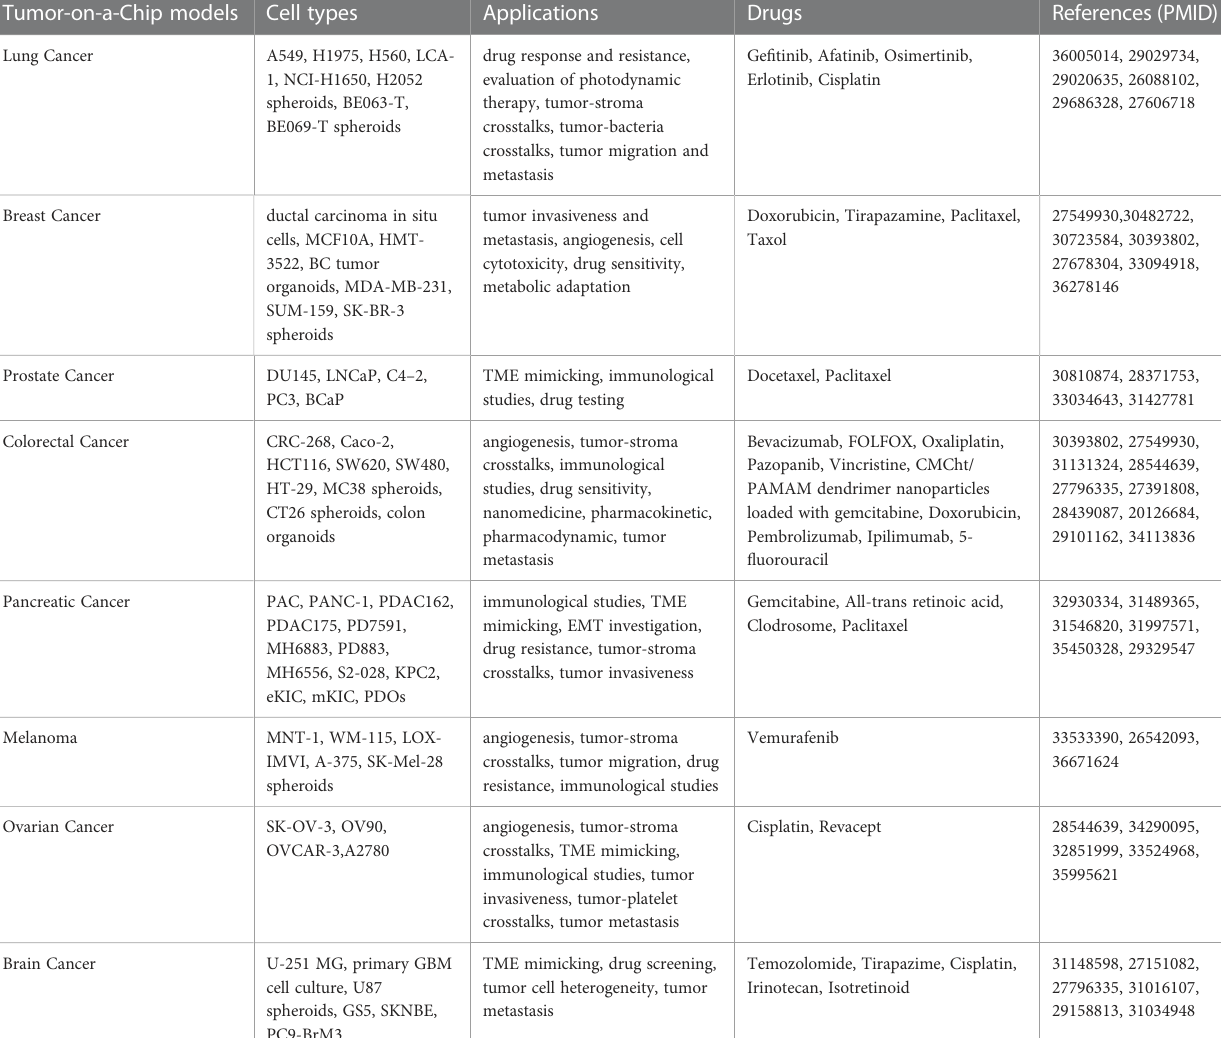
TABLE 1 Summary of Tumor-on-a Chip